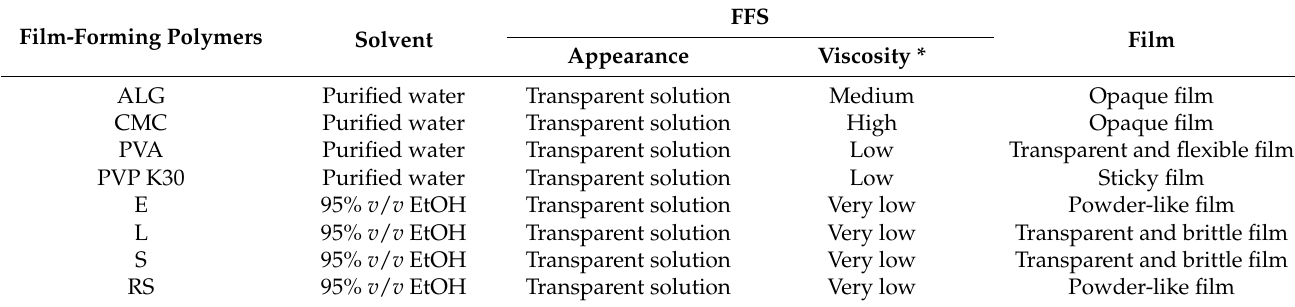
Table 1. Physical appearance of FFS and polymeric films.